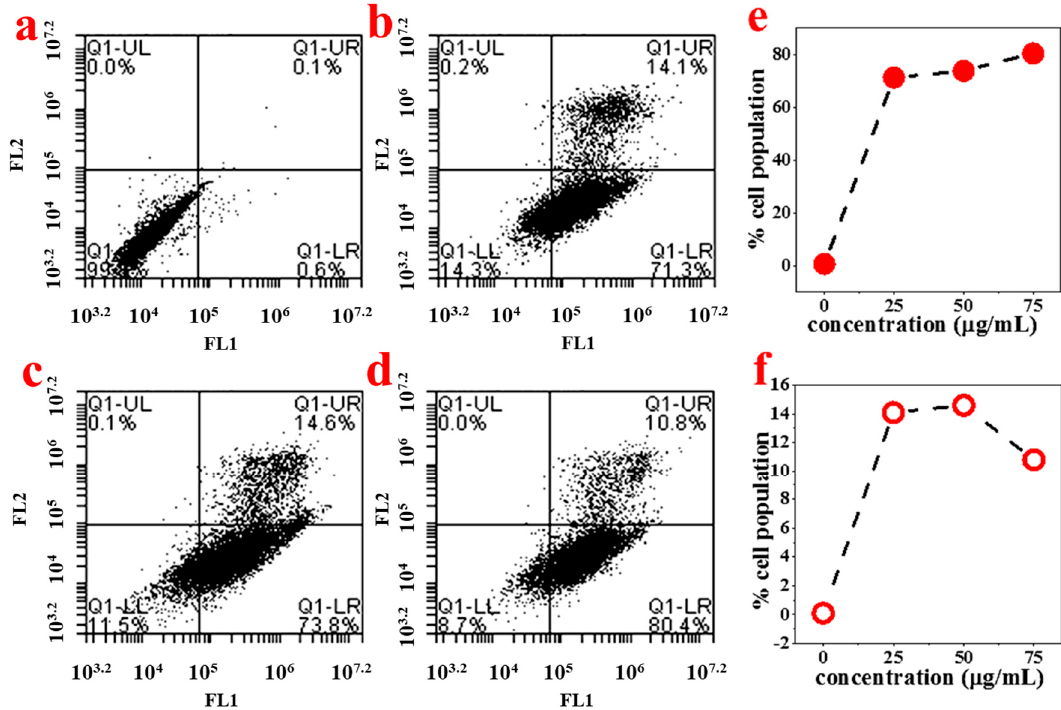
Figure 8. Histograms from FACS analysis at each ABMP concentration. The FL1 channel was used to detect annexin V-FITC staining, and the FL2 channel was for PI staining. ( a ) Control; ( b ) 25 μ g/mL; ( c ) 50 μ g/mL; ( d ) 75 μ g/mL; ( e ) percentage of early apoptotic cells stained with annexin-V-FITC at various concentrations of ABMP; ( f ) percentage of late apoptotic or necrotic cells stained with both annexin V-FITC and PI at various concentrations of ABMP.